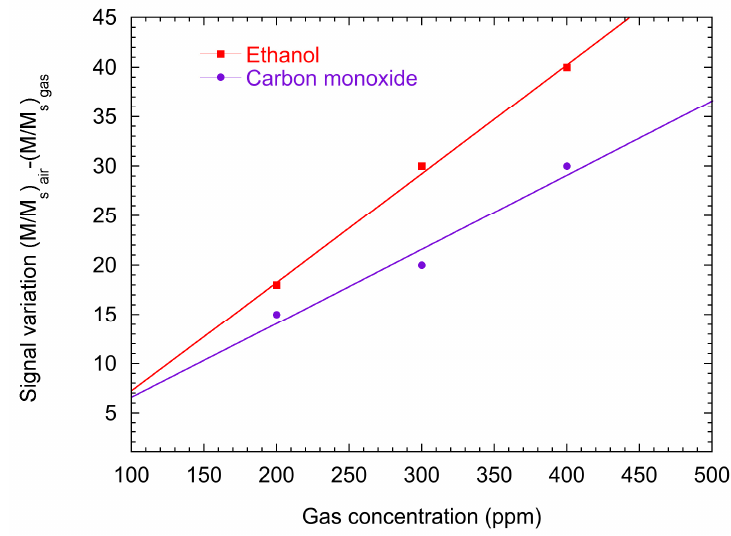
Figure 12. Sensor response of the magneto-optical gas sensor to H 2 and CO concentration (200-300-400 ppm) in dry synthetic air. Measurements are carried out at room temperature.